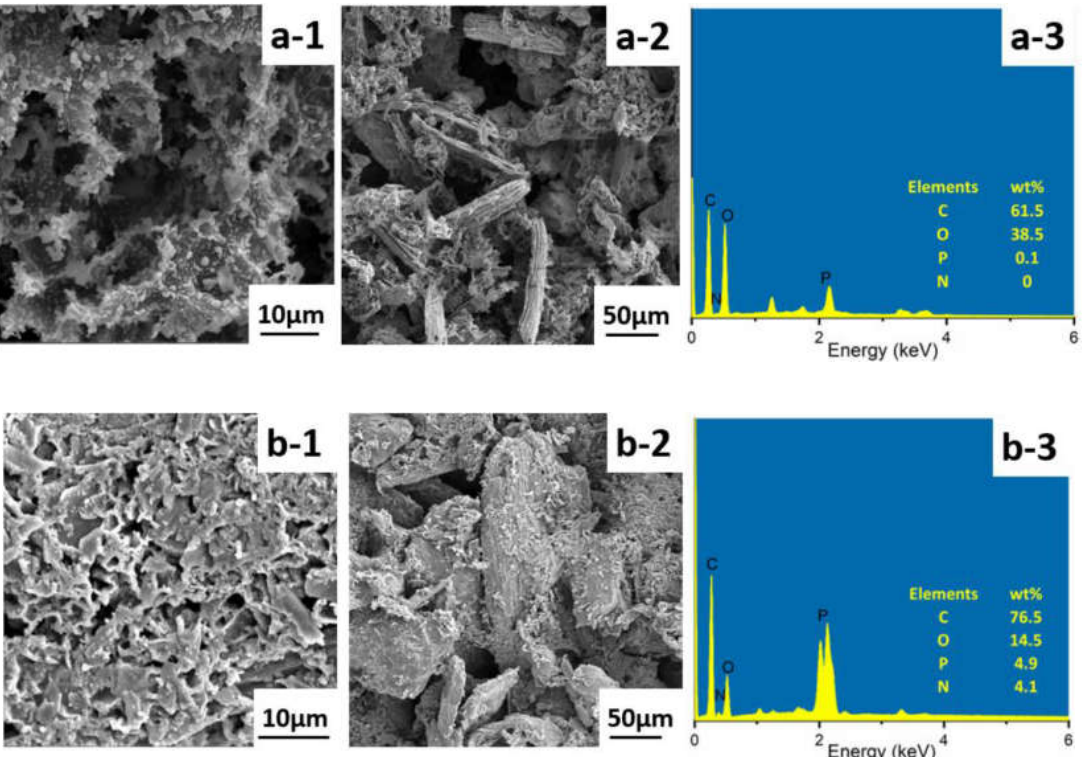
Figure 11. Morphology and elements analysis of the char residue surface after cone calorimeter test for NPC0 and NPC2: ( a-1 ) external part of NPC0; ( a-2 ) internal part of NPC0; ( a-3 ) EDS for NPC0 char residue; ( b-1 ) external part of NPC2; ( b-2 ) internal part of NPC2; ( b-3 ) EDS for NPC2 char residue. The residue of NPC0 demonstrated a discontinuous and loose surface with big voids.